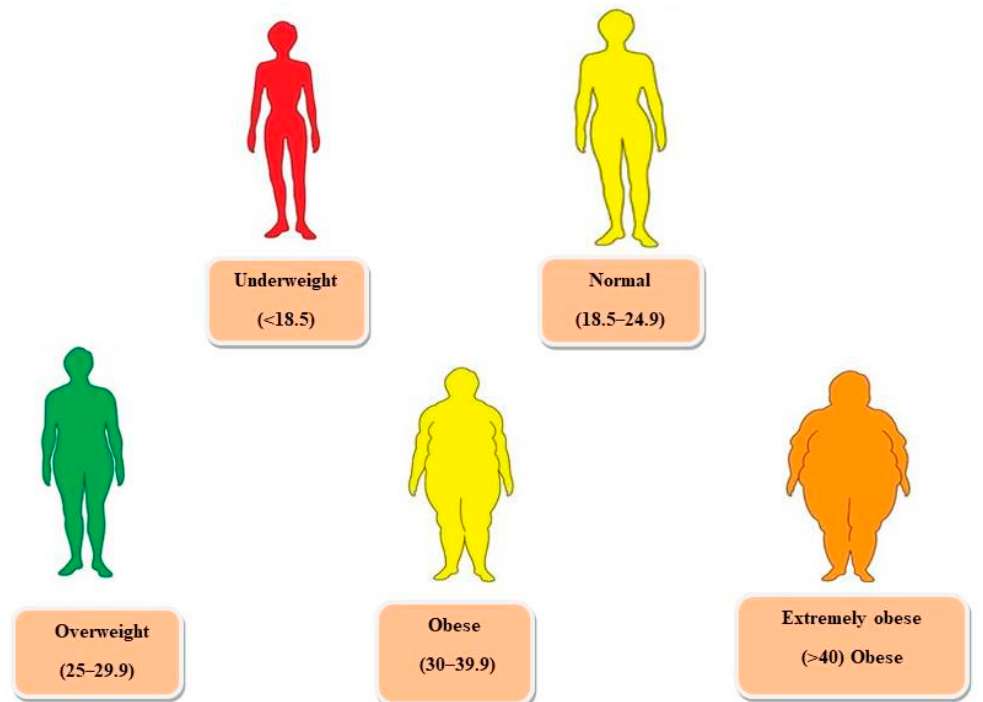
Figure 1. Classification of weight according to body mass index